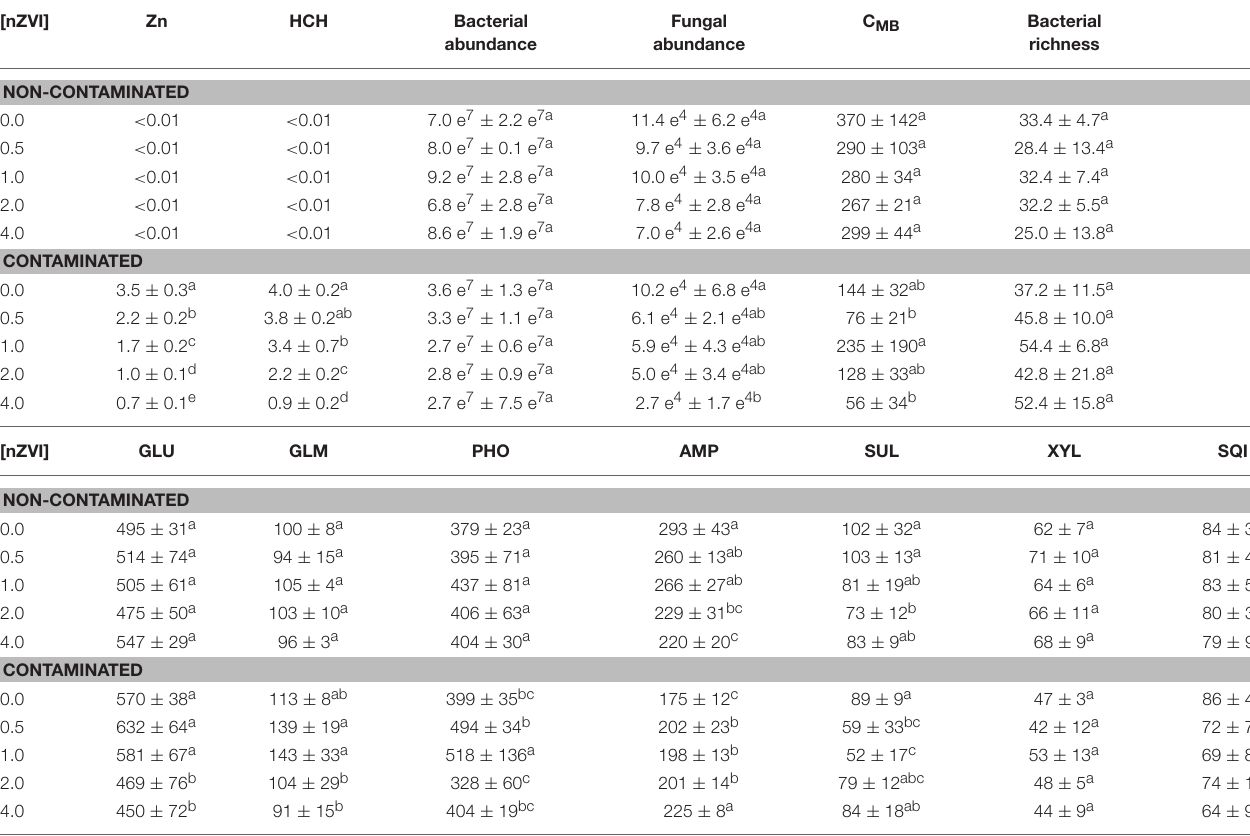
TABLE 1 | Effect of nZVI on soil microbial